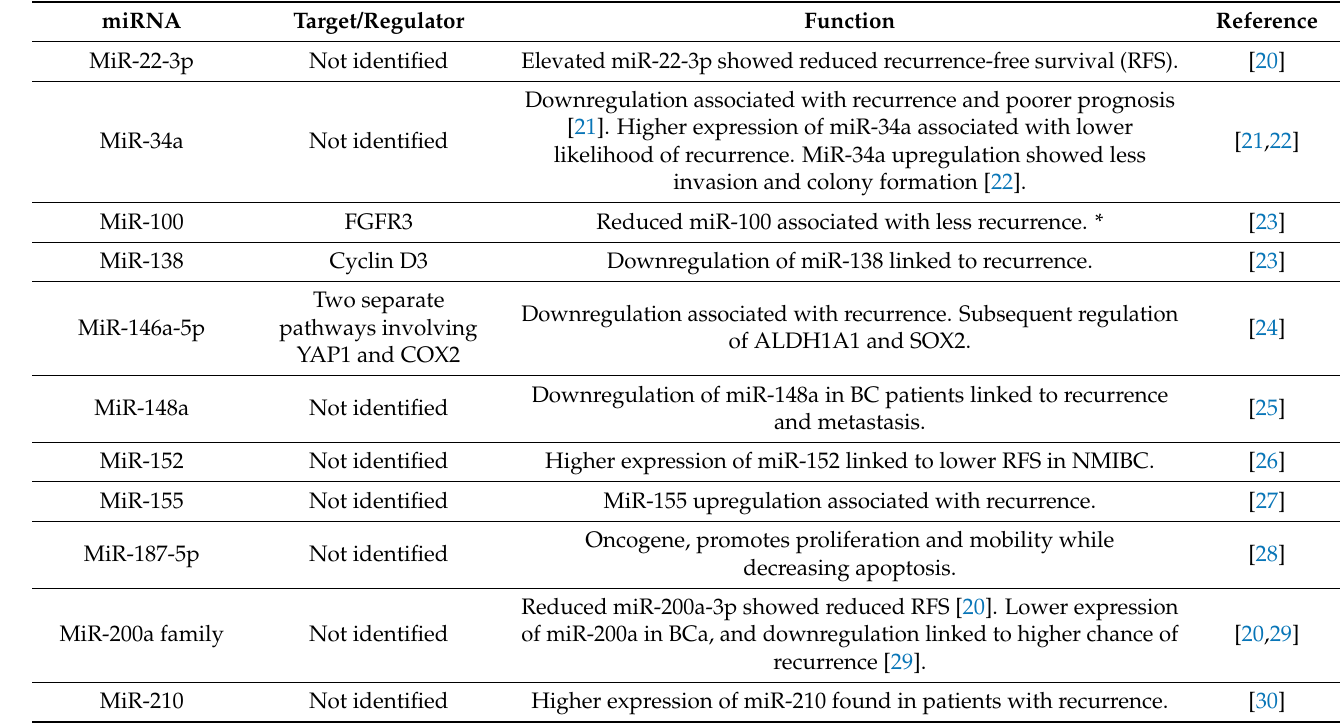
Table 1. miRNAs and associated targets/regulators involved in BCa recurrence.